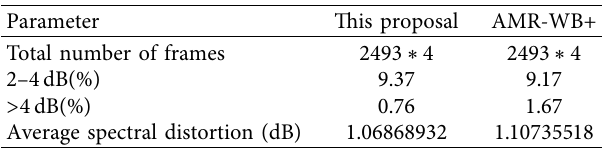
Table 5: Spectrum of the proposal and Anoto lattice code at 12.65kbps coding